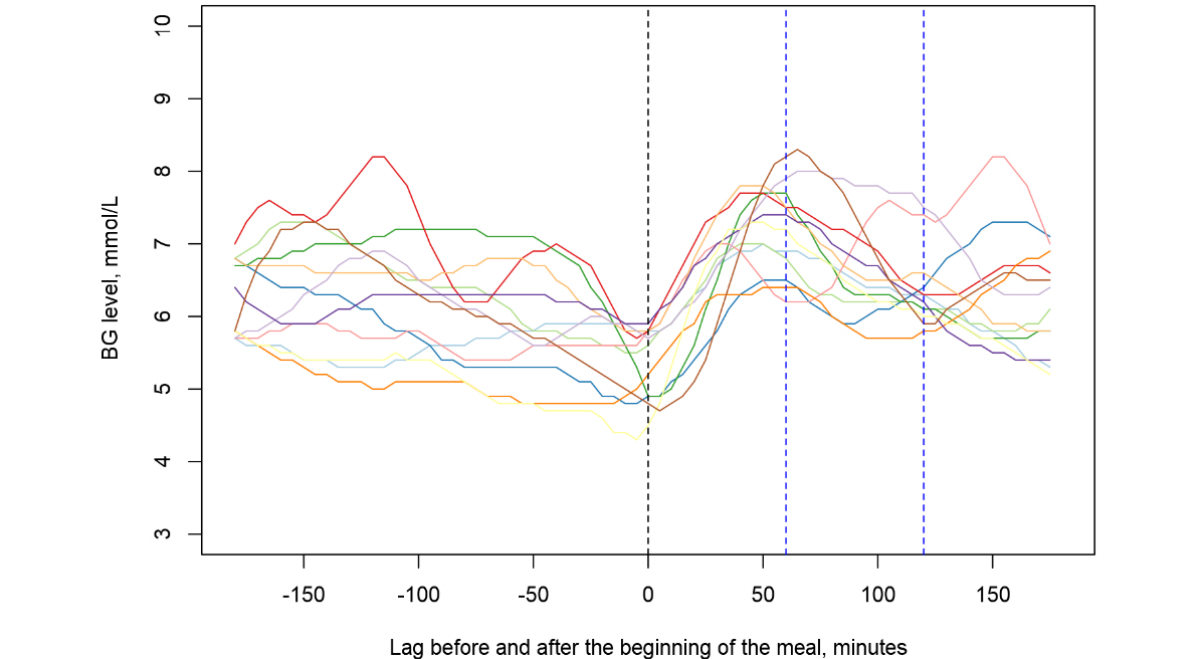
Figure 2. Ensemble of blood glucose (BG) curves collected 3 hours before and after meals for one of the patients. Different colors represent different